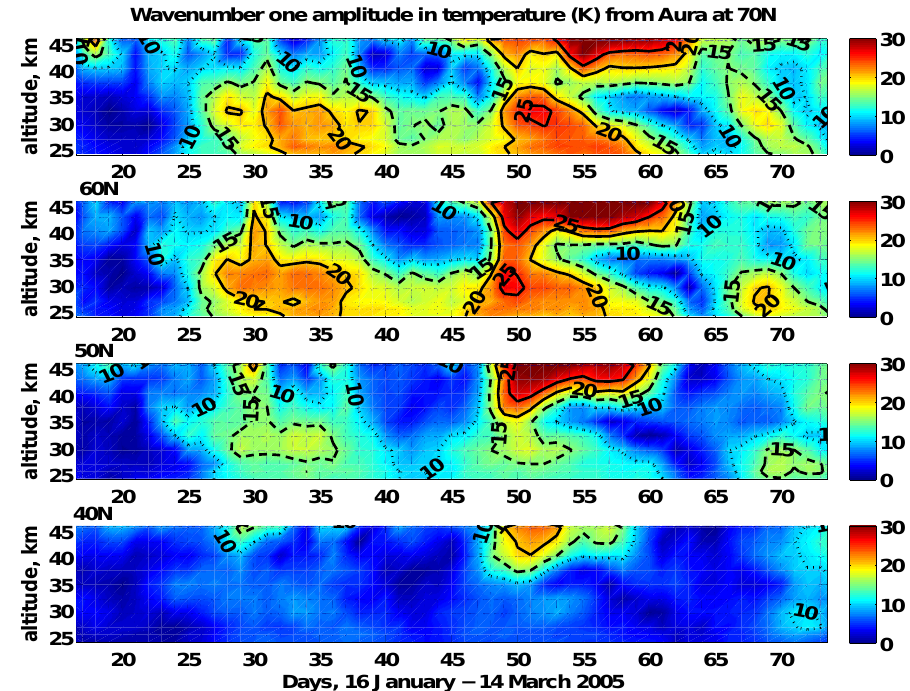
Fig. 13. Wavenumber one amplitude in temperature (K) from Aura MLS data at 70 ◦ N, 60 ◦ N, 50 ◦ N and 40 ◦ N.